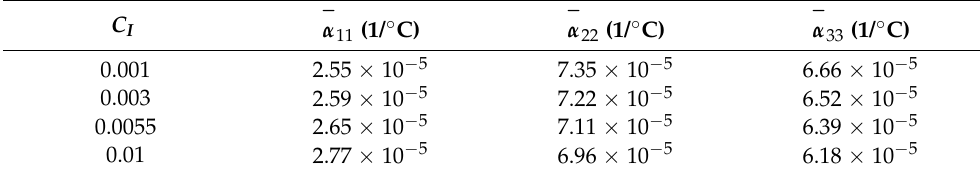
Table 4. Computed mean coefficients of thermal expansion of 13 wt.%. CF/ABS deposited bead. C